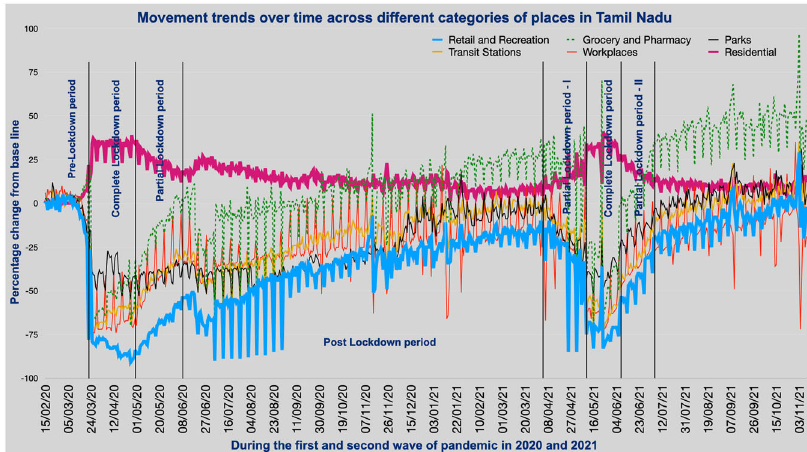
Fig. 3 Percentage change in mobility from baseline in six community spaces (land use functions) is represented on the Y -axis, while the differing intensities of lockdown in two waves of COVID-19 are shown on the X -axis with date timeline (dd/mm/yy). The vertical bars indicate the phases of lockdown (CL complete lockdown, PL partial lockdown, Post-L is post-lockdown). Source: Community Mobility Report for Tamil Nadu, Google.